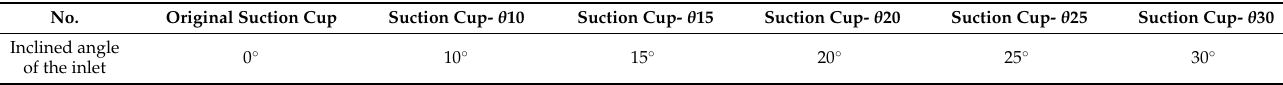
Table 2. Nomenclature of the test suction